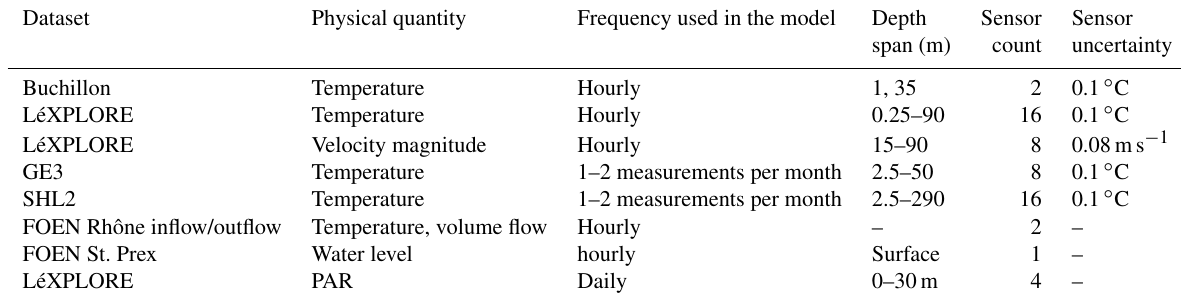
Table 2. Characteristics of the in situ datasets. Note that we assume the FOEN river and water level data to be exact.